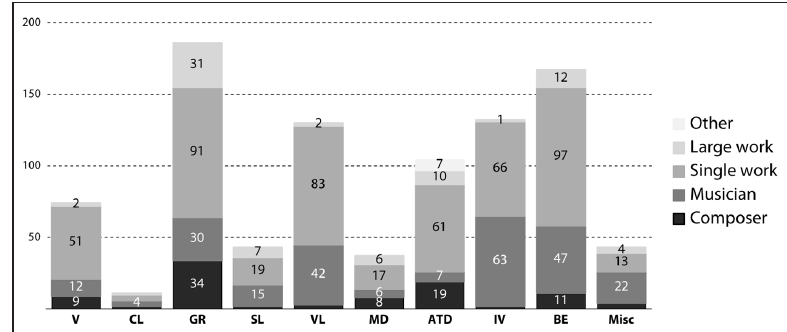
Figure 5: Type of reference (absolute) per book, N = 927.